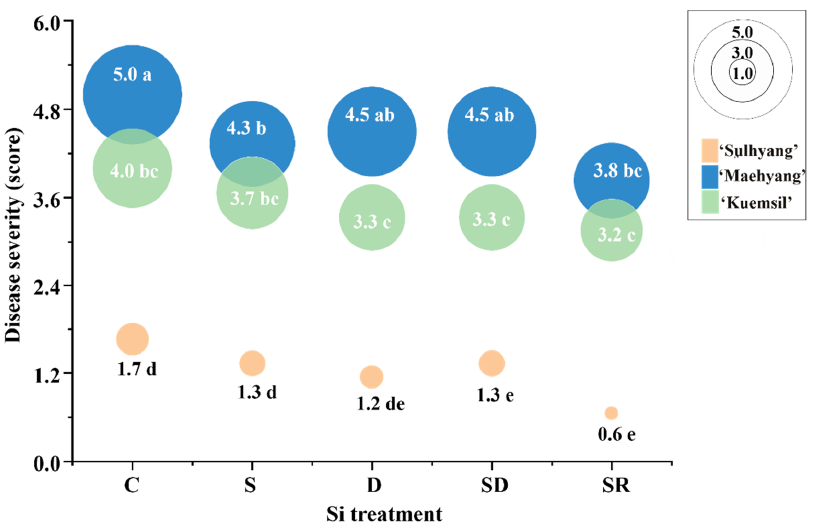
Figure 2. The powdery mildew severity in strawberry “daughter” plants after Si treatments. Low- ercase letters indicate significant differences calculated by the Duncan’s multiple range test at p ≤ 0.05: C, control; S, sprayed “mother” plant; D, drenched “mother” plant; SD, dressed “mother” plant; and SR, sprayed “daughter” plant.